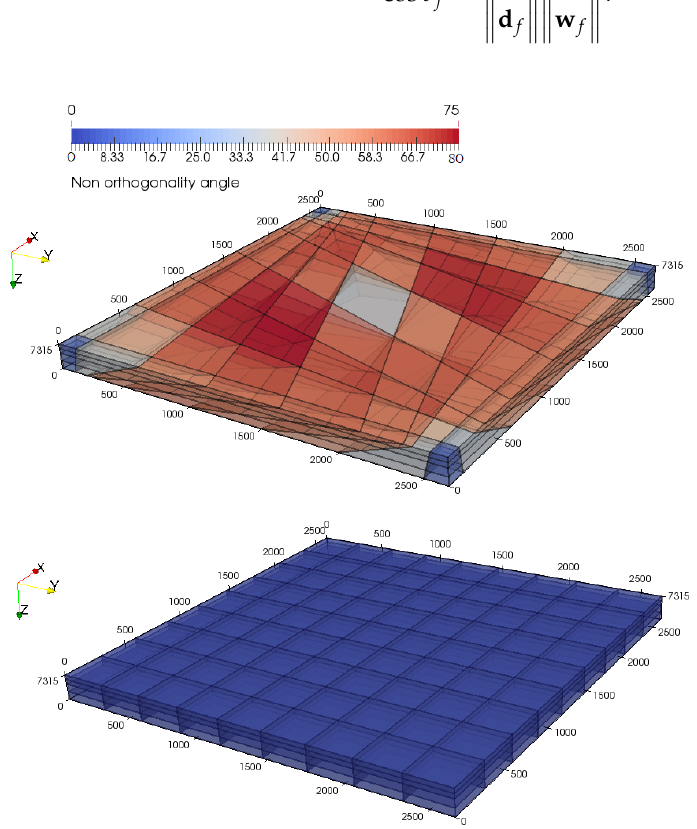
Figure 6. SPE 3 adapted test geometries: Non-orthogonal ( top ) and reference orthogonal ( bottom